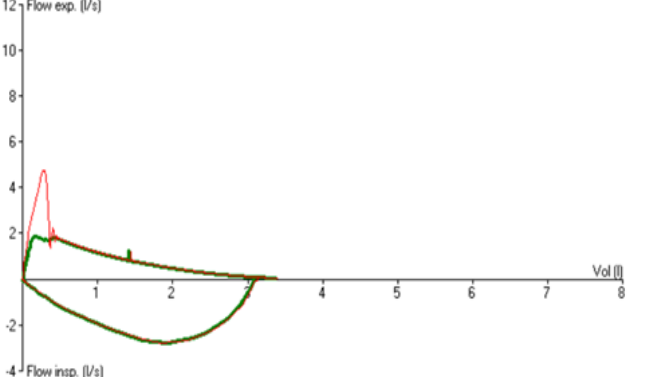
Figure A1. A part of the computer screen during the work of the Tgol.e-spirometry system for e-learning of spirometry. An example that may explain to students the h-shaped flow – volume loop that is observed in severe obstructive lung diseases. The thin line is the loop observed by physicians, and the bold line is the loop that would be if only airflow from lungs could be observed (the difference between both loops is caused by air exhaled from collapsing bronchi at the beginning of the forced expiration).